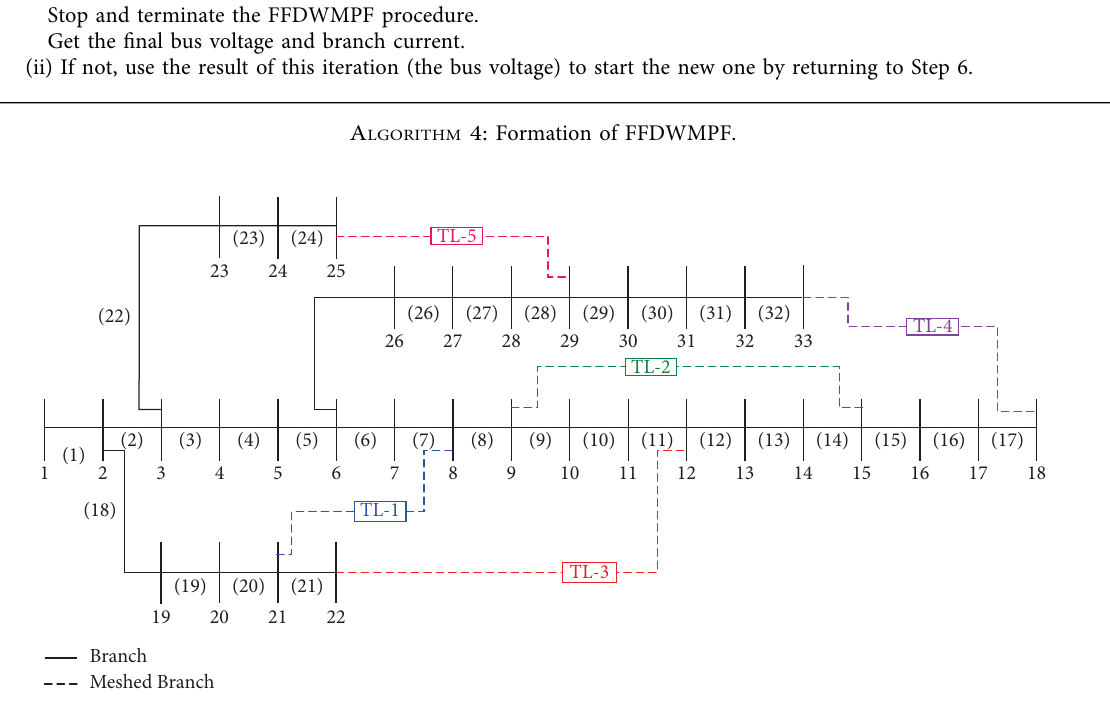
Figure 4: Tirty three-bus weakly meshed distribution system.